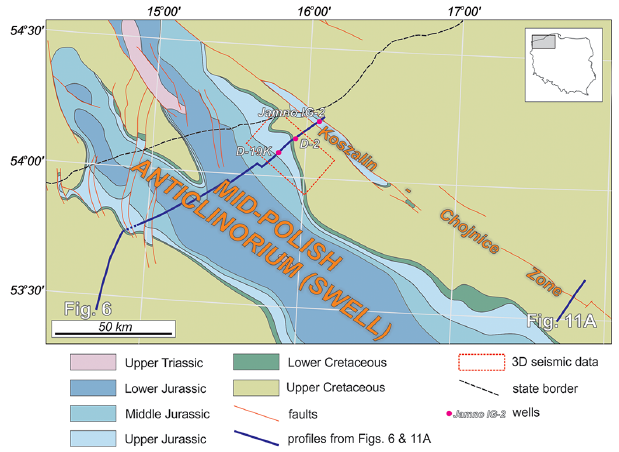
Figure 5. Geological map of NW Poland without Cenozoic (after Dadlez et al., 2000,